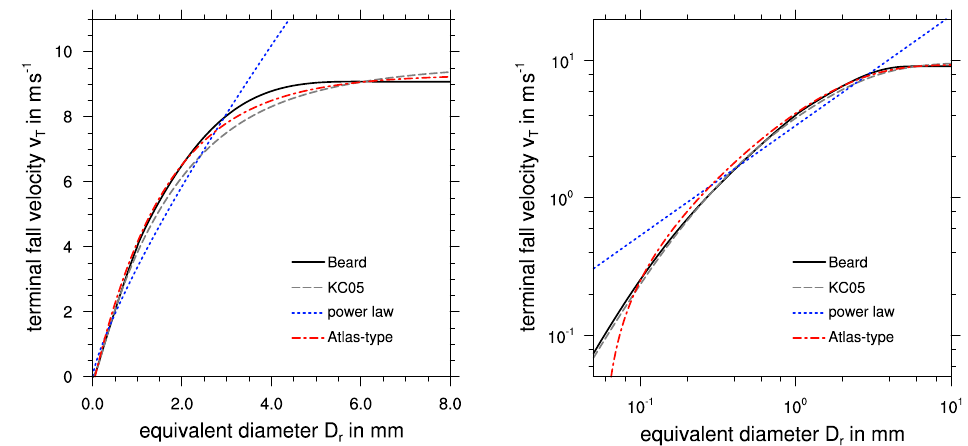
Fig. 2. Terminal fall velocity of raindrops as a function of equivalent diameter using different approaches. The empirical relation of Beard (black solid line) is regarded as the reference. The aerodynamic theory of Khvorostyanov and Curry (2002) can explain the empirical behavior, but significant differences exist (grey dashed line). The power-law approximation (blue dotted line) is in general inappropriate, but the Atlas-type relation (red dash-dotted line) gives a good approximation for raindrops larger than 0.1 mm. Table 1. Coefficients for the mass-size relation x = ˆ aD ˆ b , the maximum dimension as function of particle mass D = ax b , the power law terminal fall velocity v ( x )= αx β of particles with mass x and the shape parameters of the Gamma distributions f ( x )= Ax ν exp( − Bx ξ )